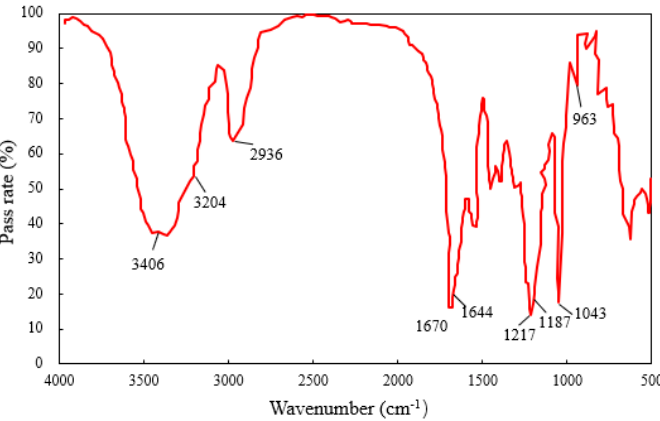
Figure 8. FI-IR spectrum of polymer.